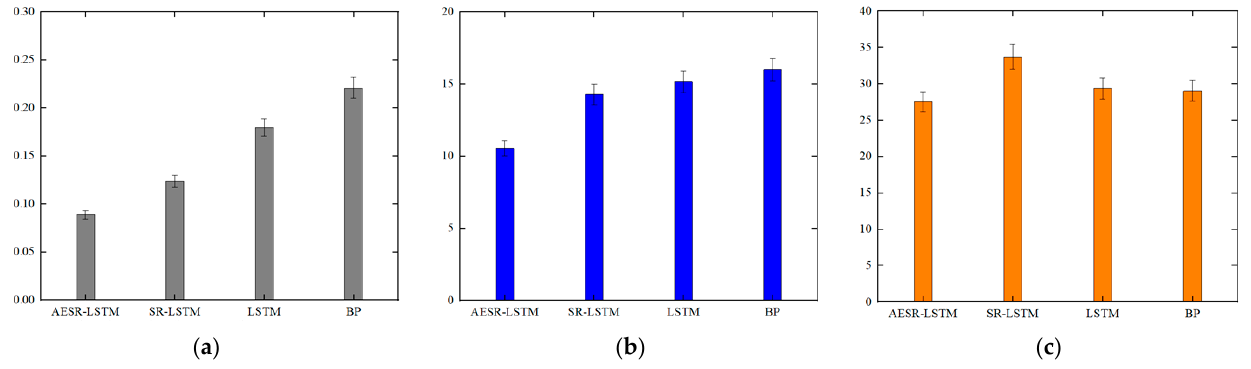
Figure 12. Comparative results histogram of model evaluation metrics: ( a ) MAPE value histogram